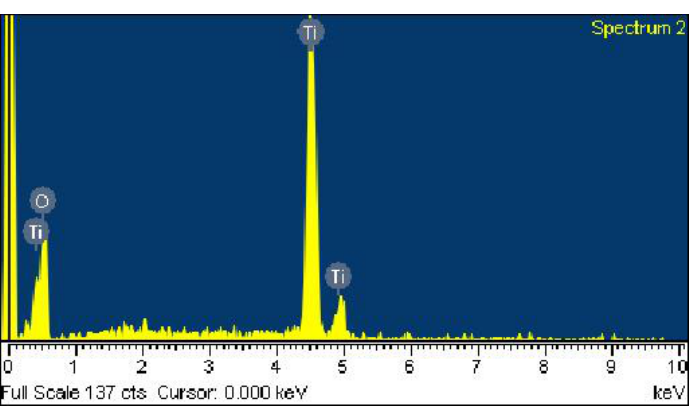
Figure 5. EDS analysis of the titanium dioxide